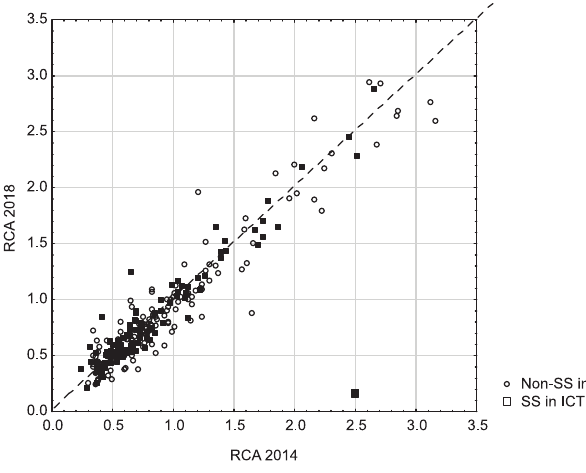
Figure 2. Changes in RCA value by non-SS in ICT and SS in ICT groups – NUTS2 regions (2014, 2018) (source: